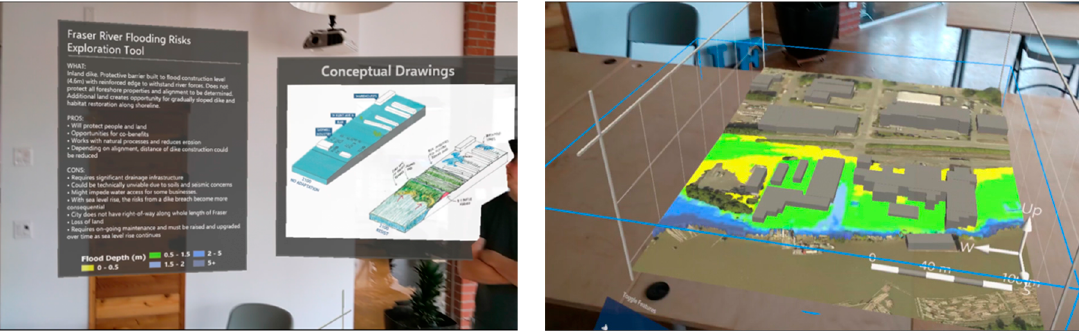
Figure 6. (Top) Shared version of MR prototype in a conference room environment. Displayed is a default layout of content on launch, that can be further adapted to the environment. (Bottom) Single user MR visualization adapted to the shared workspace environment. The 3D visualization (Right) is placed on a table and information panels (left) are aligned to a nearby wall. You can also notice dynamic occlusion of a person standing in front of the conceptual drawings panel.